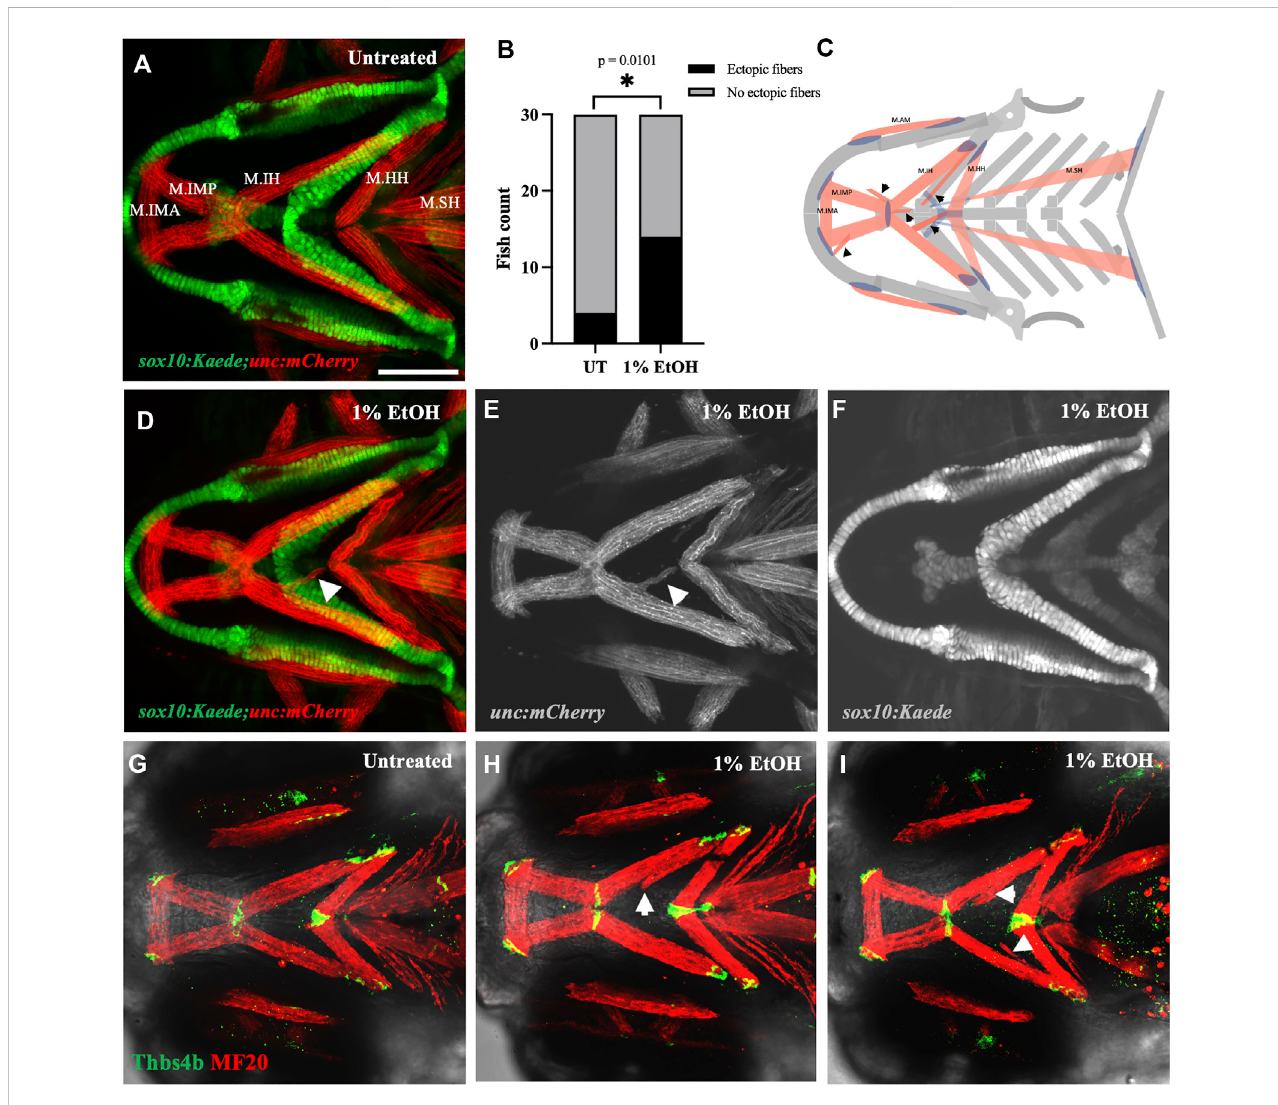
FIGURE 3 Ethanol induces ectopic muscle fi bers (A) Ventral view of branchial skeleton and muscle in untreated sox10:Kaede;unc:mCherry fi sh at 4dpf. (D – F) Ethanol-exposed sox10:Kaede;unc:mCherry fi sh at 4dpf. Arrows show ectopic muscle fi ber in D & E. (B) Ectopic muscle fi bers signi fi cantly increase in the ethanol-exposed fi sh. (C) Schematic showing locations of ectopic muscle fi ber defects observed in the ethanol-exposed fi sh. (G) Untreated isl1:RFP fi sh immunolabeledwith MF20 (heavy chain of myosin II) in red and Thbs4b (Thrombospondin 4 b) in green. (H, I) MF20 & Thbs4b immunolabeled, ethanol- exposed isl1:RFP fi sh. Arrows show ectopic muscle fi bers lack ectopic tendons. * = p < 0.05. Scale bar = 100